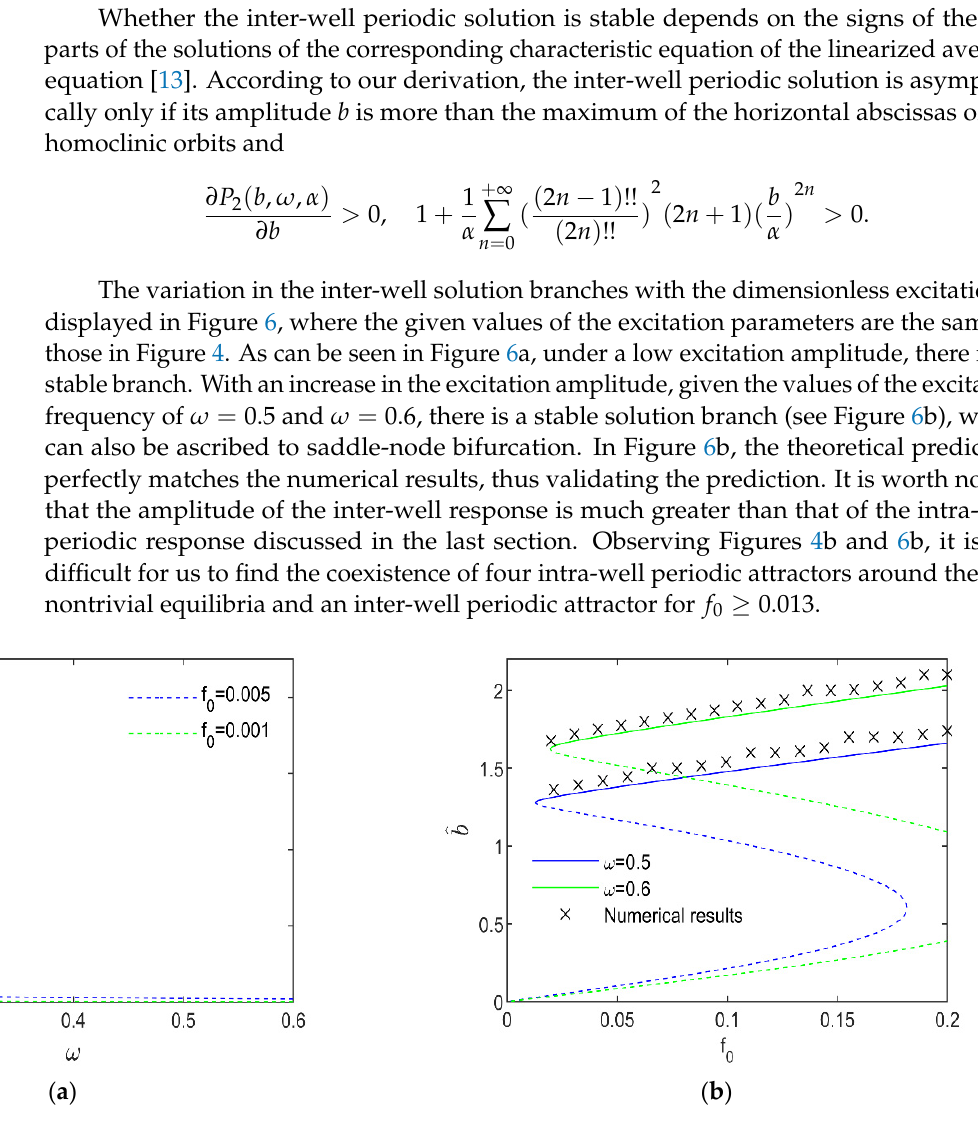
Figure 6. Variation in the amplitude of the inter-well periodic solution with excitation: ( a ) amplitude of the periodic solution vs. ω ; ( b ) amplitude of the periodic solution vs. f 0 .